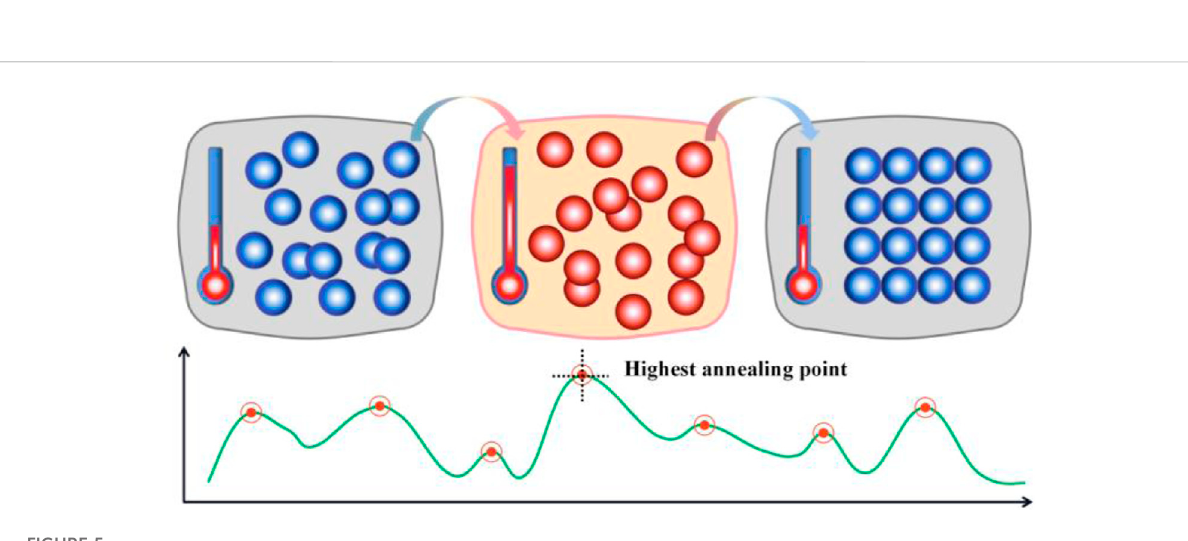
FIGURE 5 Principle of the simulated annealing